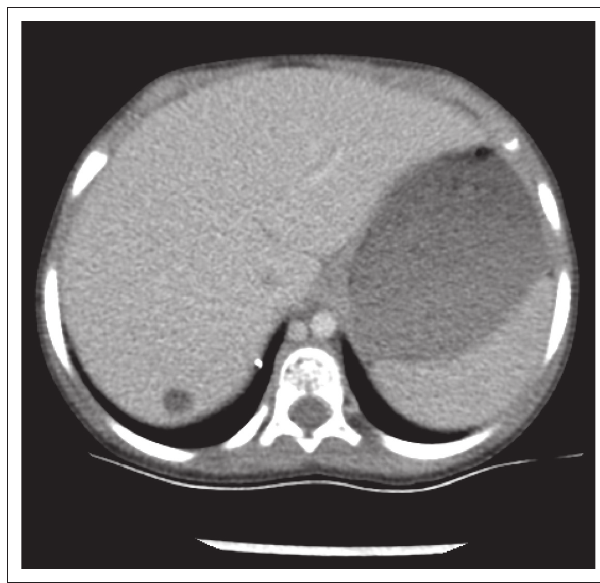
Source : Figure provided by authors. FIGURE 3: Follow-up abdominopelvic CT in a patient, previously in remission following treatment for stage II nephroblastoma, shows a well-defined hypodense lesion in the right lobe of the liver. This lesion was not present on baseline imaging and had increased in size compared with a previous follow- up CT, making the lesion highly suggestive of a liver metastasis. The patient subsequently underwent liver resection. Histology revealed hydatid disease.